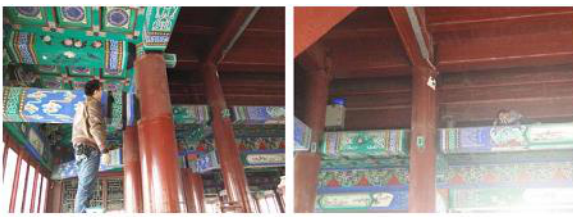
Figure 4. The locations of apparatus